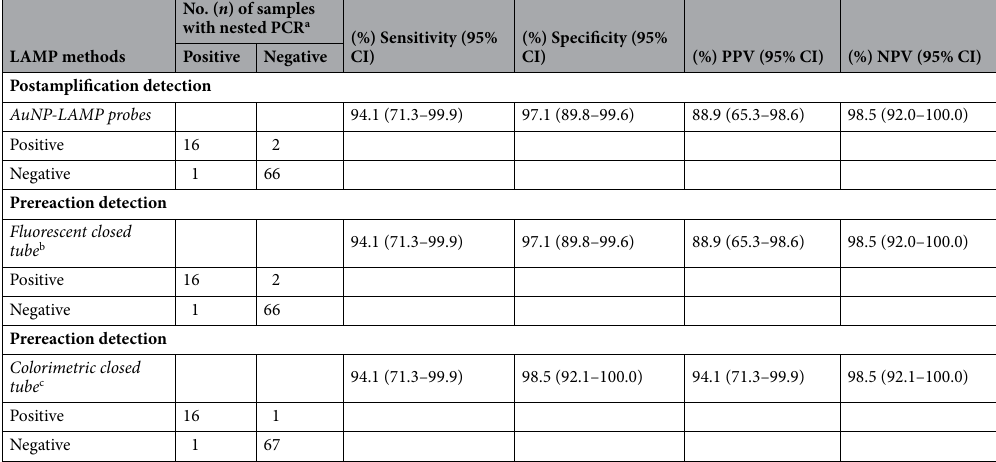
Table 1. Sensitivity and specificity of postamplification detection using specific AuNP-LAMP probes and prereaction detection using other nonspecific dye indicators in LAMP assays to detect Leishmania DNA among patients with asymptomatic leishmaniasis. a Total number of positive results was based on nested PCR (reference standard method); b SYBR safe initially mixed in the reaction before salt induction of postamplification detection was used as a fluorescent indicator; c SYBR green I was used as a color